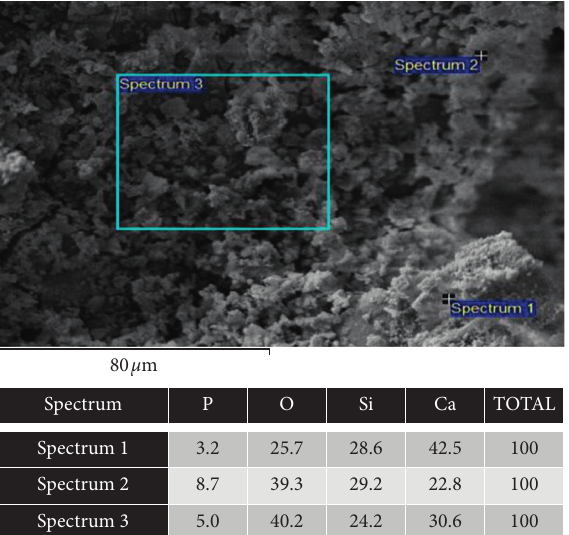
Figure 3: Representative scanning electron micrographs of the composite and the elemental mapping at different areas. EDS detected stronger silicon signals of Ca, Si, P, and